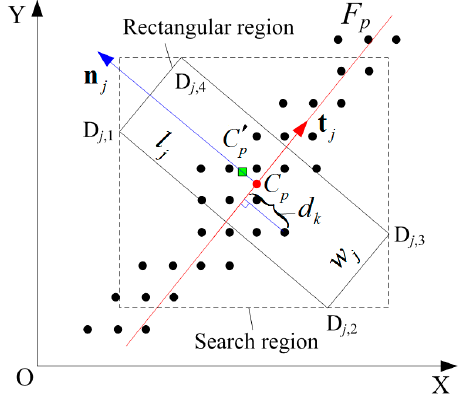
Figure 1. Principle for center extraction using the improved gray-gravity method (IGGM).